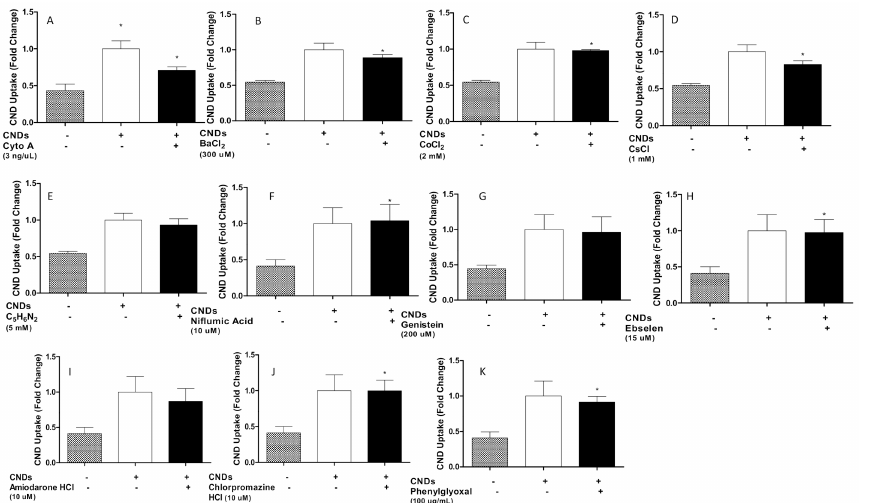
Figure 8. Chemical inhibitors’ effect on uptake of CNDs into macrophages ( Panel A : cyto A; Panel B : BaCl 2 ; Panel C : CoCl 2 ; Panel D : CsCl; Panel E : C 5 H 6 N 2 ; Panel F : Niflumic Acid; Panel G : Genistein; Panel H : Ebselen; Panel I : Amiodarone HCl; Panel J : Chlorpromazine HCL; Panel K : Phenylglyoxal). THP-1 monocyte-derived macrophages (1 × 10 6 ) were treated for 30 min with or without inhibitors. Next, cells were treated with 0.1 mg/mL CNDs for 24 h. Lastly, cells were harvested and placed in a 96-well plate. Fluorescence analysis ensued in a BioTek™ Synergy 2.0 plate reader. All data represent mean ± SEM. ( n = 3, *, p < 0.005 vs